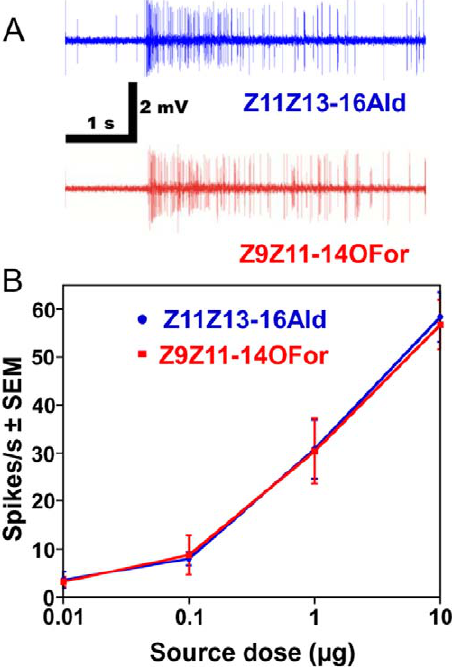
Figure 1. Responses of the peripheral olfactory system of the navel orangeworm to the major constituent of the sex pheromone and its formate analog. (A) Extracellularly recorded single unit responses from ORNs housed in a trichoid sensillum on the antennae, and (B) dose-dependent relationships ( n =5; error bar in all figures represent SEM).